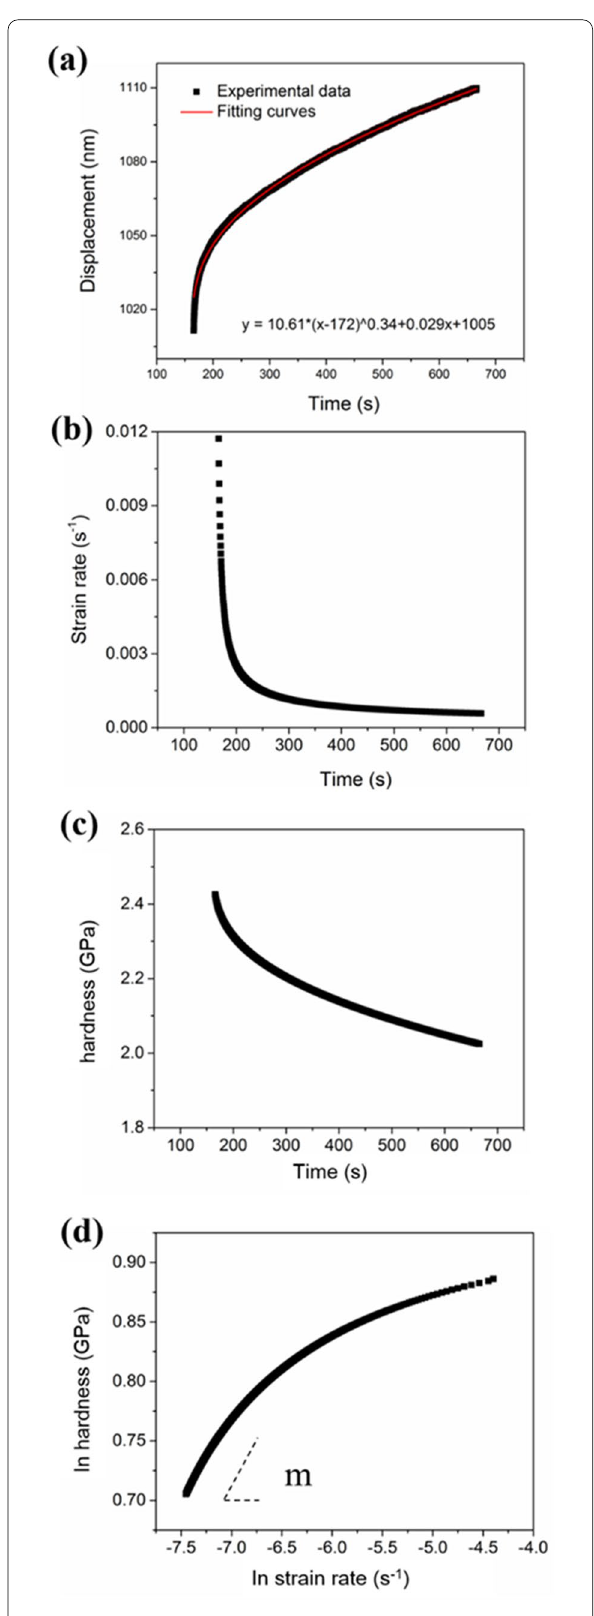
Figure 13 ( a ) Fitting curves using Eq. 1, ( b ) Variation in strain rate deduced from Eq. 1, ( c ) Decreased hardness during dwell period, ( d ) The log correlation between hardness and indentation strain rate: the SRS (m) value can be estimated by linearly fitting the steady-state creep